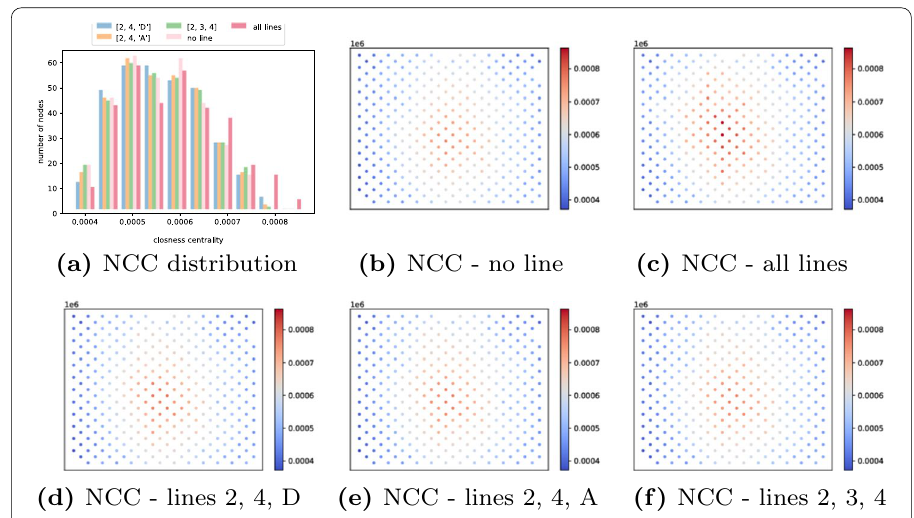
Fig. 6 Histogram of node closeness centrality and its spatial distribution in the studied